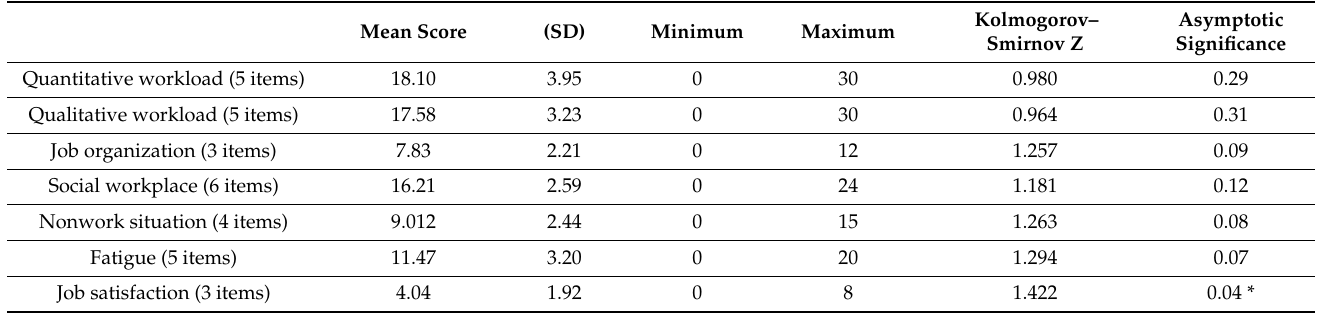
Table 1. Workload and stress factors determined from the variables and normal distribution compati- bility